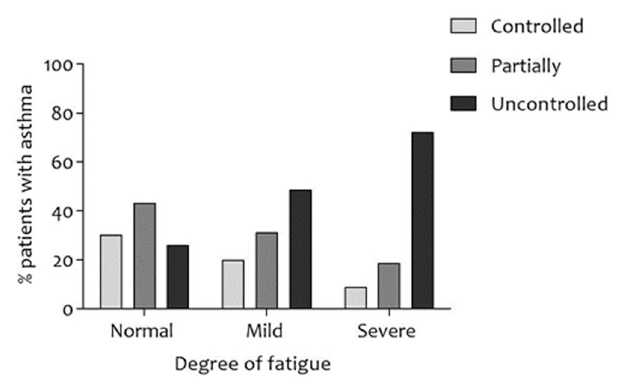
Figure 3. Proportion of asthmatic patients with controlled (ACQ ≤ 0.75), partially controlled (ACQ 0.76–1.49), and uncontrolled asthma (ACQ ≥ 1.5) after stratification for the degree of fatigue. A statistically significant association between degree of fatigue and degree of asthma control was observed; χ 2 (4, n = 664) = 93.073, V = 0.265, and p < 0.001. ACQ: Asthma Control Questionnaire; n : number of subjects; V : Cramer’s V.